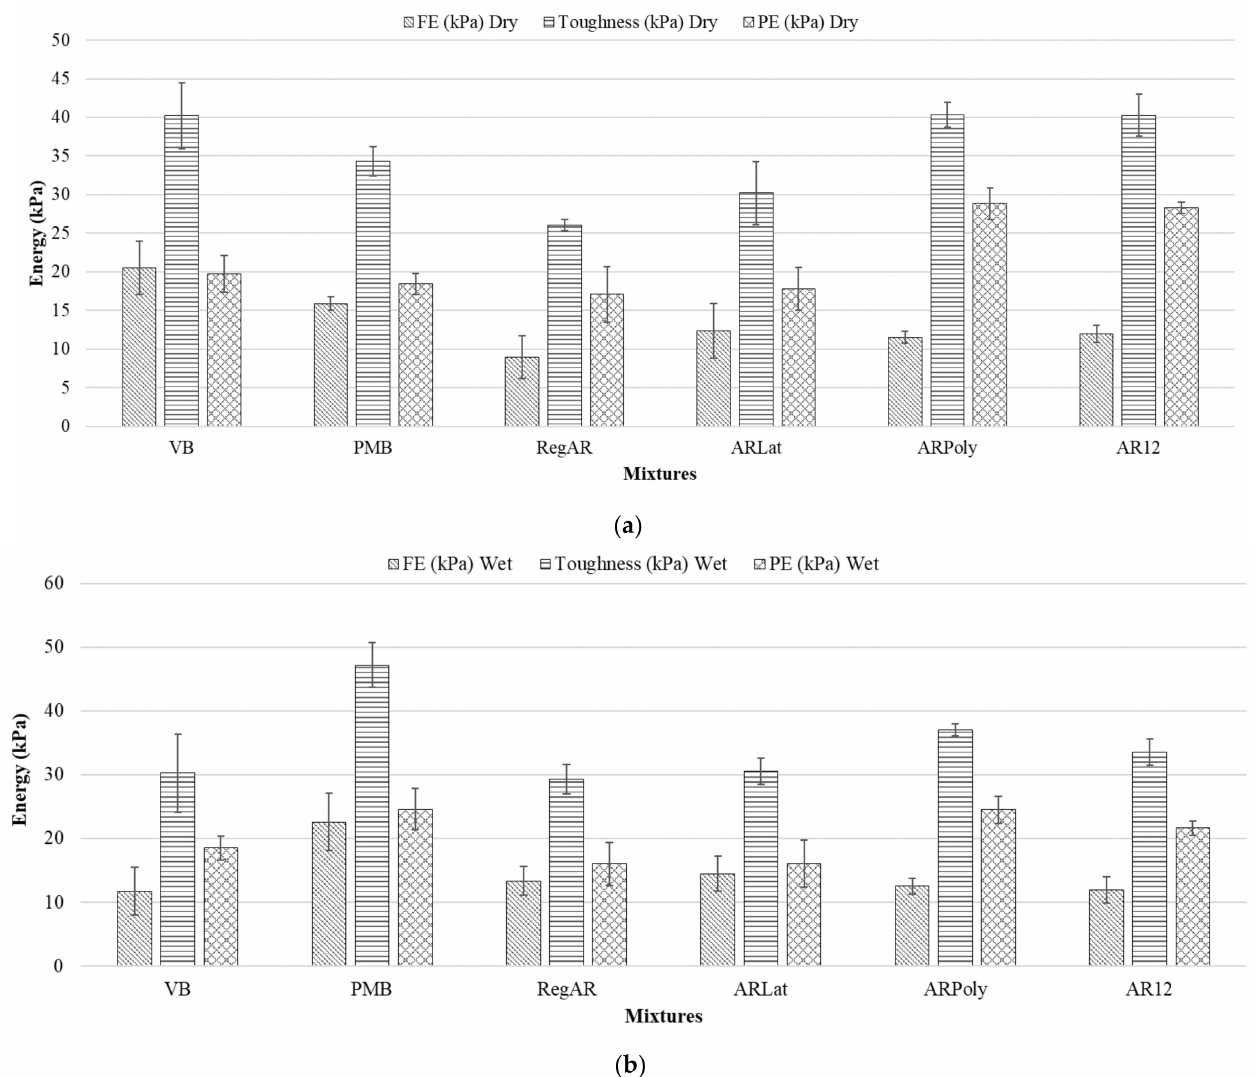
Figure 6. Mean values of fracture energy (FE), post-cracking energy (PE), and Toughness: ( a ) dry conditions ( b ) wet conditions, error bars indicate the standard deviation by